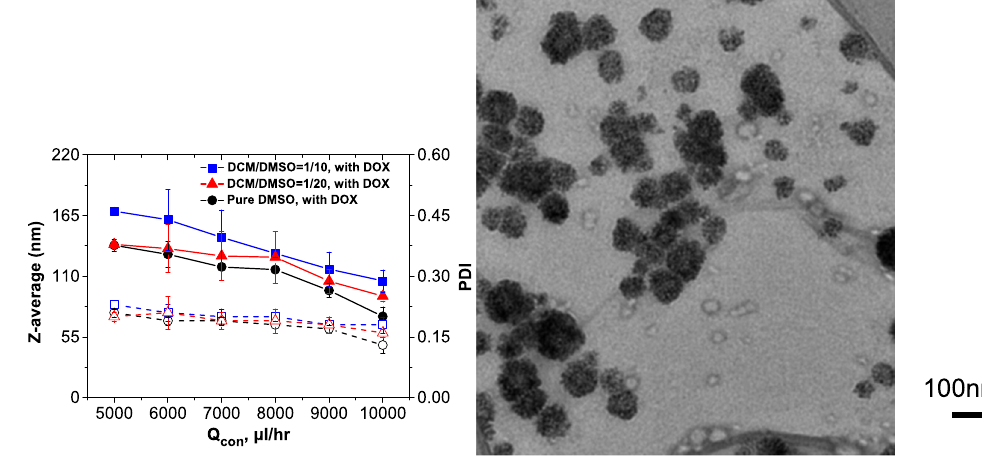
Figure 6. Size of DOX-encapsulated PLGA NPs synthesized with precursor solvents of different flowrate ratios and different compositions V DCM /V DMSO . The solid markers represent the particle hydrodynamic sizes and the open ones the polydispersity index (PDI) as deduced by 2 nd order Cumulant fit of the correlogram curves. Qdis = 50 µ L/hr. Concentration of PLGA (Mw = 4000~15000 g/mol) = 5 mg/mL. Concentration of Doxorubicin = 1 mg/mL. (n = 3; mean ± S.D.). TEM image of DOX-PLGA NPs (the scale bar is 100 nm) to demonstrate spherical shape of the nanoparticles.